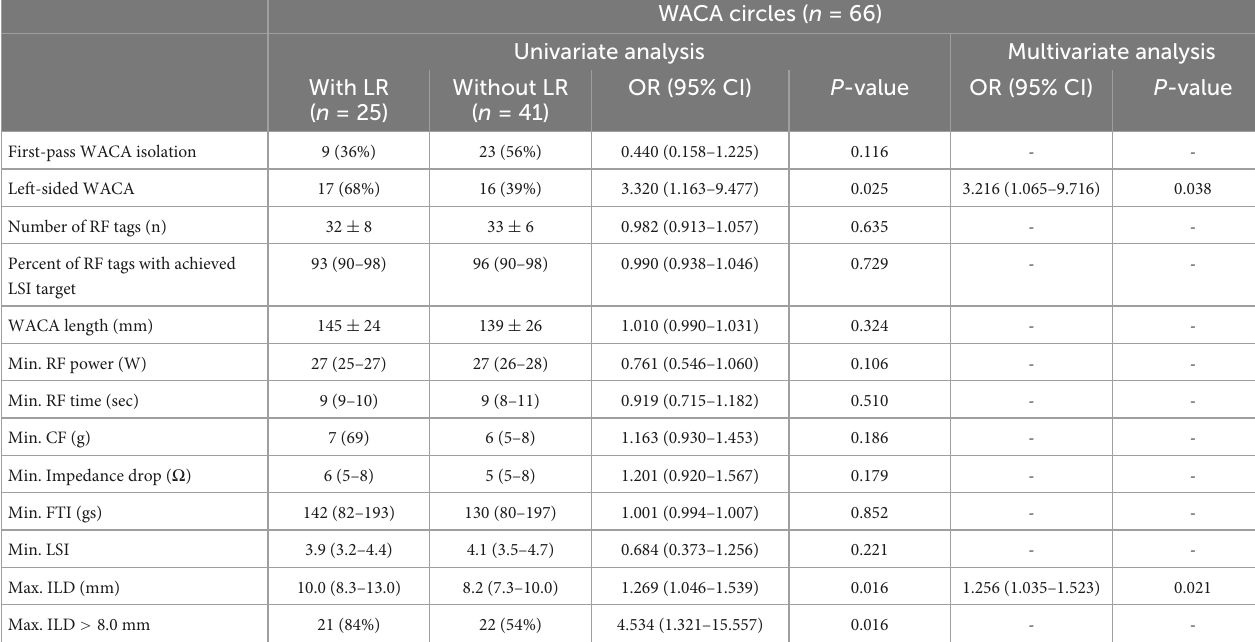
TABLE 4 Risk factors for the late WACA circle